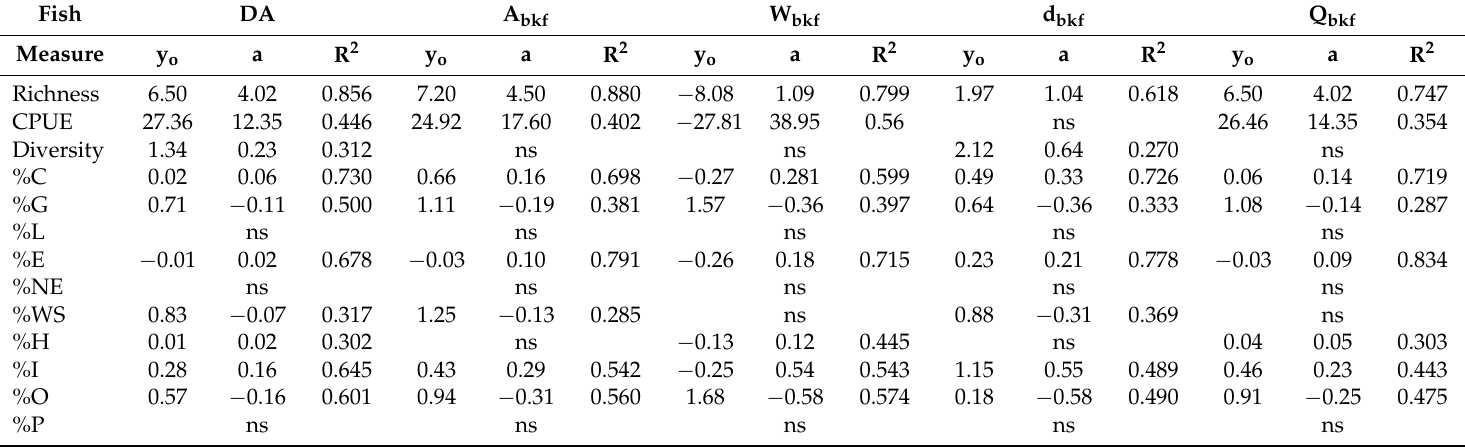
Table 6. Significant ( p < 0.05) relationships between measures of fish assemblages and bankfull dimensions for 16 Alabama Piedmont reference streams. Values are the intercept (y o ), slope (a), and coefficient of determination (R 2 ) for the logarithmic model y = y o + a ln x, where y is the fish measure and x is the bankfull dimension measure. See text for definitions of fish and geomorphic